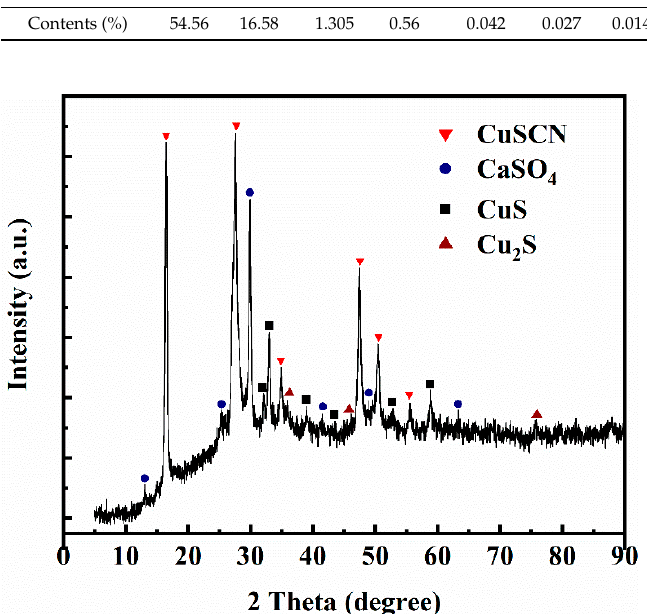
Figure 9. XRD patterns of copper products.